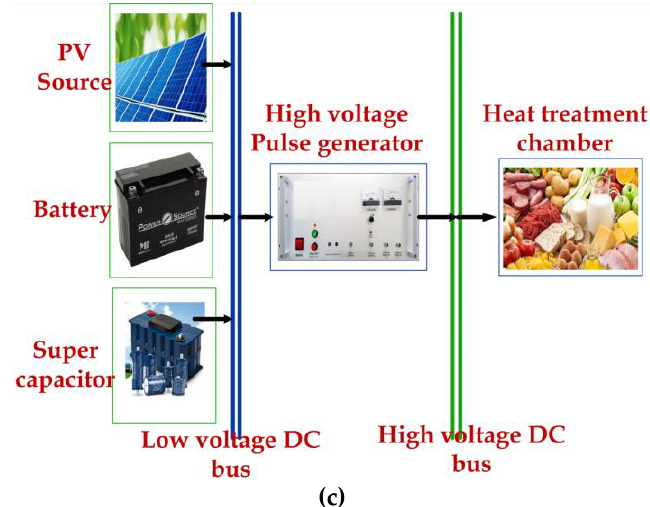
Figure 1. ( a ) PEF required for various process in food industry; ( b ) energy required for vegetable tissue drying; ( c ) general block diagram of PEF setup with high voltage pulse generator Table 1. Non thermal processing methods—limitations and